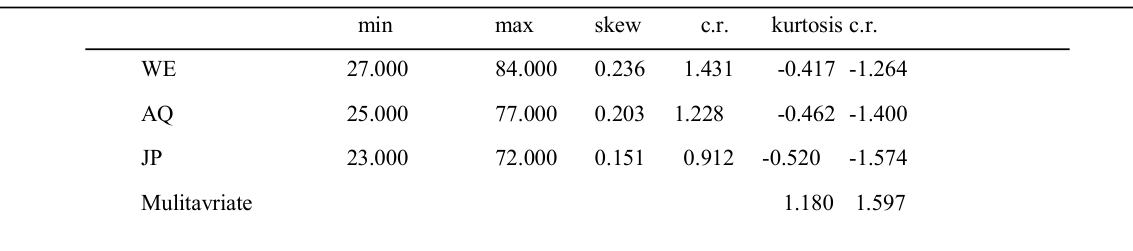
Table 4: Assessment of